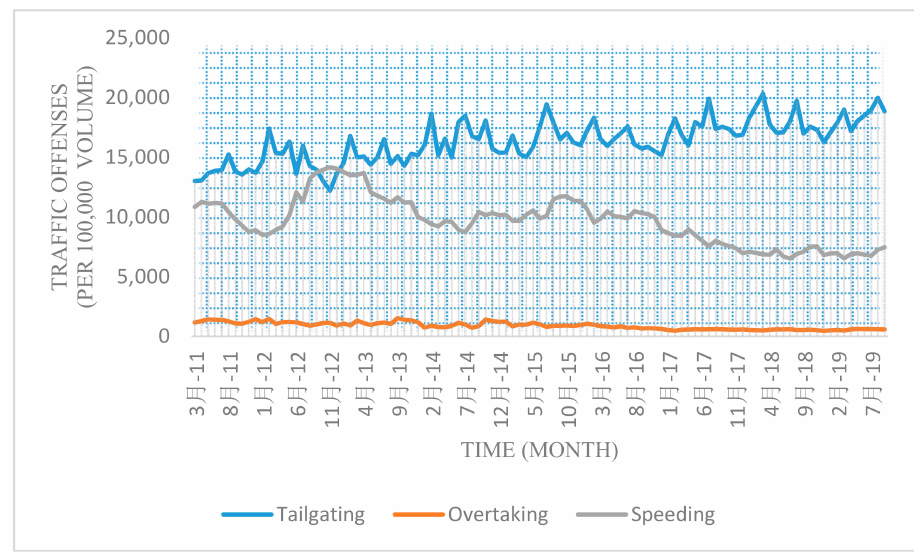
Figure 1. Incidence rate of tra ffi c o ff enses per 100,000 vehicles in Iran between March 2011 and October